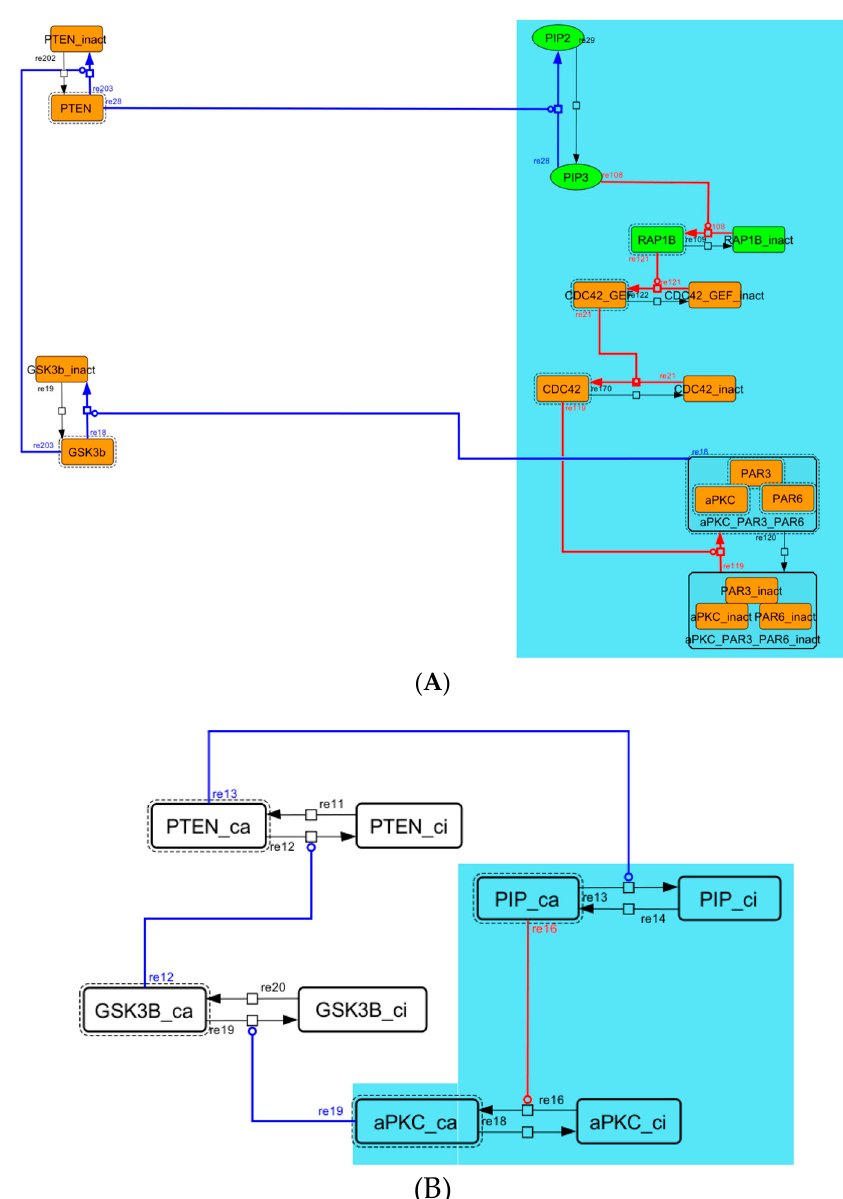
Figure A5. Diagram of the negative ‐ feedback loop between PTEN and GSK3B. ( A ) The negative ‐ feedback loop in the whole signaling network. ( B ) The contracted negative ‐ feedback loop in the toy model. Red edges represent positive regulations. Blue edges represent negative regulations. Background color shows correspondence relationship between before and after contraction.